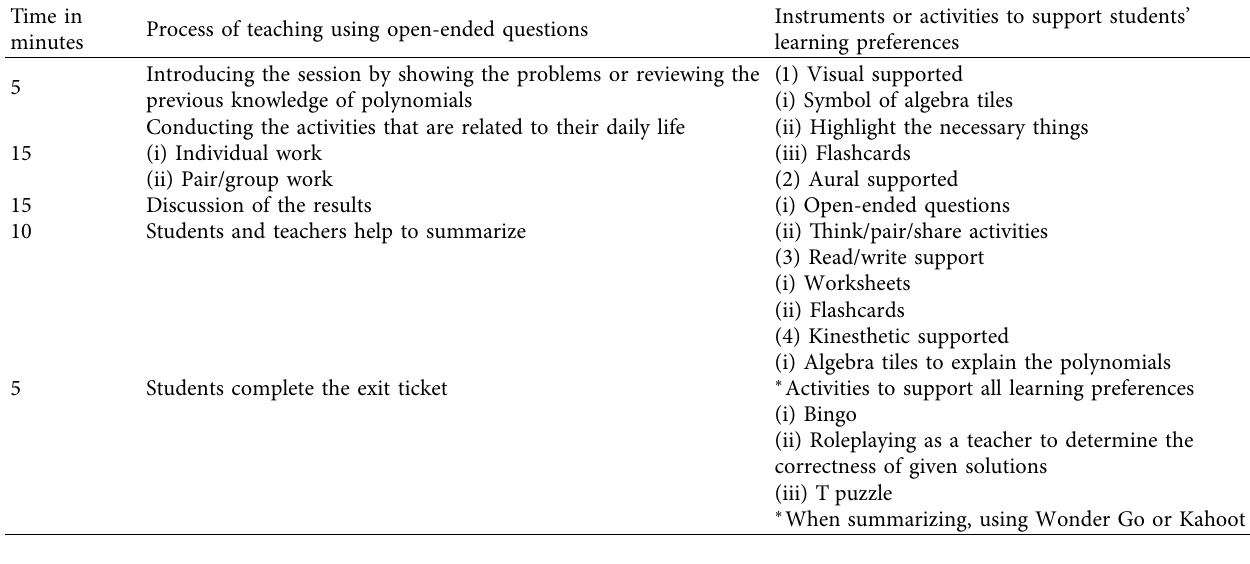
Table 1: Outline of the teaching process.